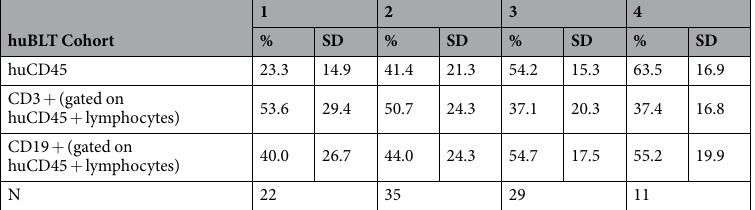
Table 1. Human cell populations in huBLT mice